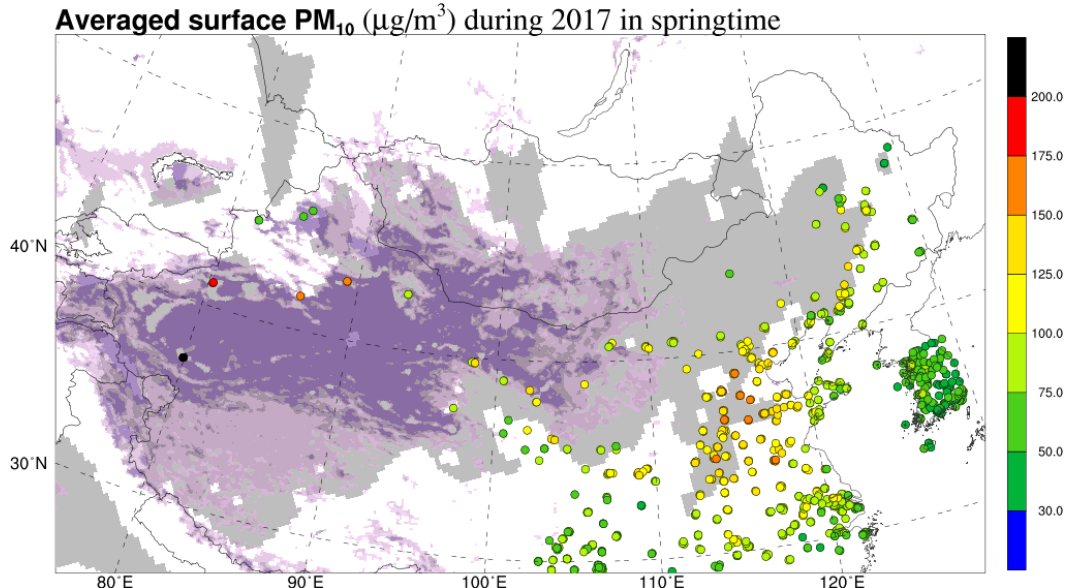
Figure 3. Surface PM 10 mass concentration observation data from 27 Korea Meteorological Administration (KMA) sites, 250 Korea Ministry of Environment (MOE) sites in South Korea, and 1498 Chinese Ministry of Environmental Protection (MEP) sites in China (units: µg m −3 ). The bare soil fraction ( B ) is 0.2–0.4 for areas in light purple and 0.4–0.6 for areas in dark purple. The gray area indicates ADAM’s Asian dust source regions.